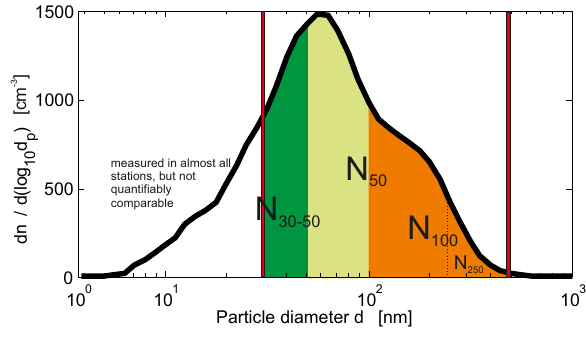
Fig. 1. Size regions used in the analysis. The red lines show the size cut-offs from 30nm to 500nm. The green area shows the re- gion used to calculate N 30 − 50 , the orange area N 100 and the total area of orange and teal are the N 50 ( N 100 is part of N 50 ). N 250 concentration (Appendix B) is shown in dotted line.